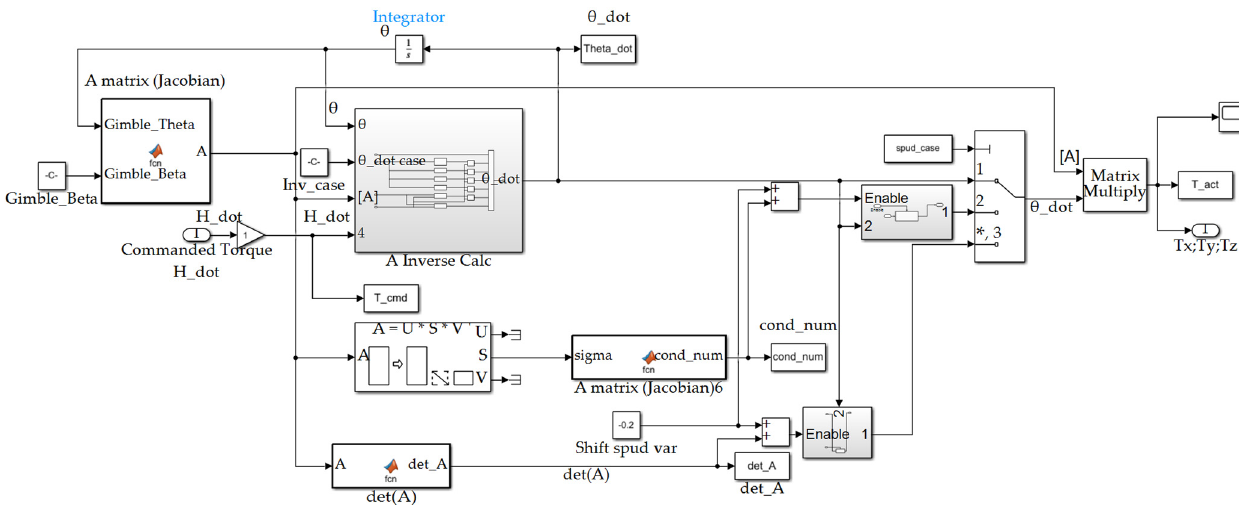
Figure A6. Actuators’ subsystem depicted in Figure A1.